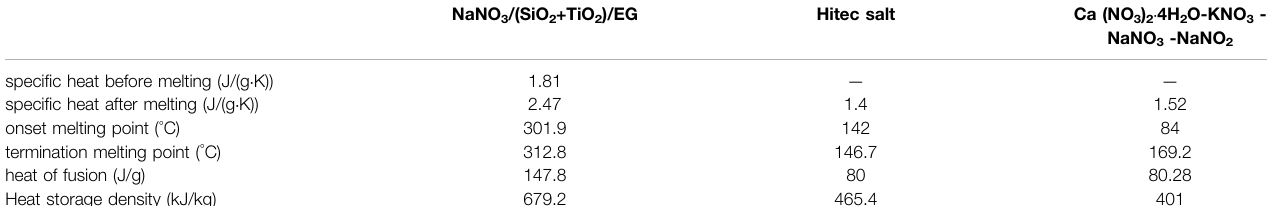
TABLE 5 | heat storage density of composite materials, Hitec salt and quaternary salt.